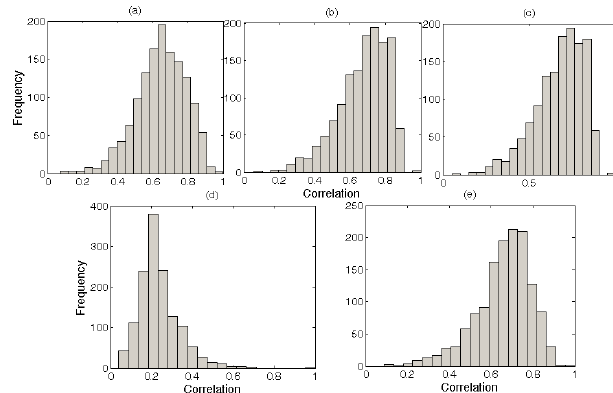
Fig. 8. Distribution of rectilinearity (left column), azimuth (middle column) and dip (right column) of the polarization of events (Sub- classes a, b, c respectively) detected in Series